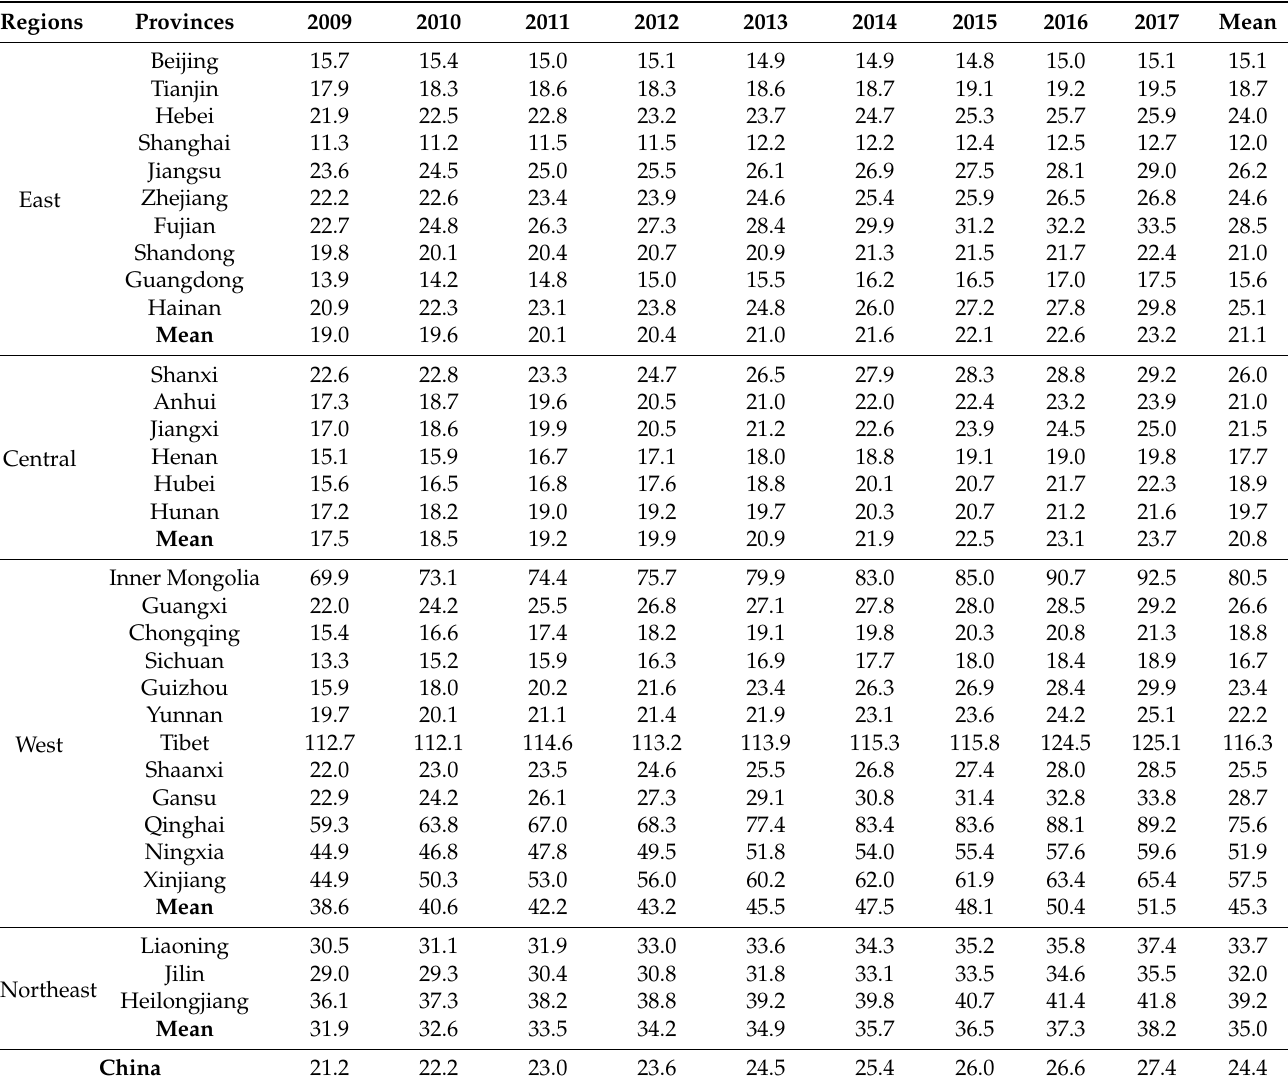
Table 2. The values of PCTLA for 31 provinces in China from 2009 to 2017 (m 2 ).